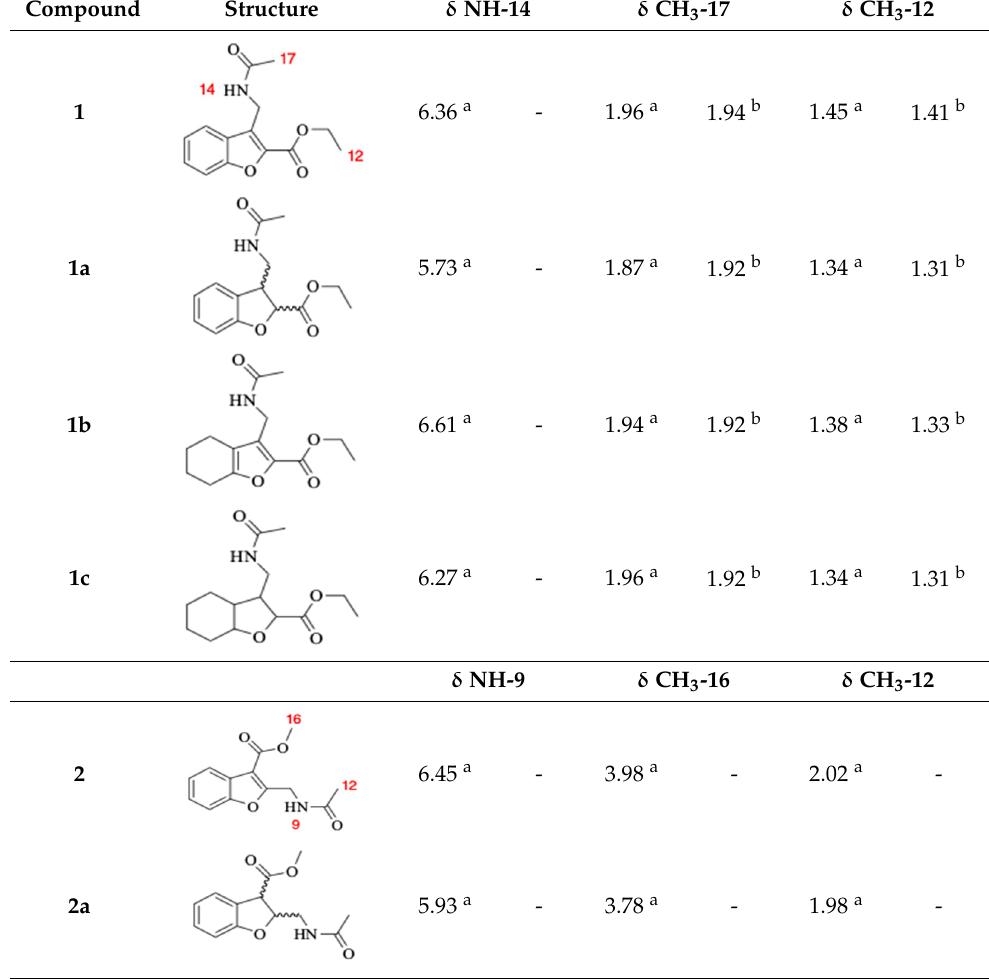
Table 1. Chemical shifts ( δ , ppm) in the proton nuclear magnetic resonance ( 1 H-NMR) spectra of the methyls in compound 1 and its hydrogenated products ( 1a – 1c ), and in compound 2 and its hydrogenated derivative 2a .